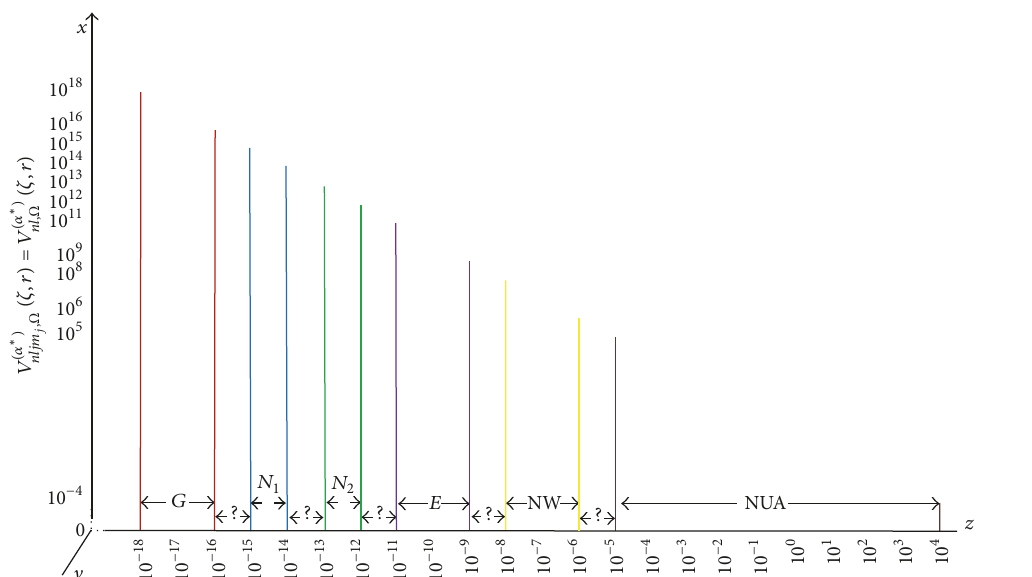
Figure 1: Quantum scalar and SF relativistic NSST potentials for 𝜆 = 0 as a function of distance 𝑟 (for 𝑧 = 𝑟 , 𝑛 = 2 , 𝑙 = 1 , 𝑗 = 1/2 , 𝑚 𝑗 = −1/2 , 𝜁 = 1.5 , 𝛼 ∗ = 0.5 ) for Ω = 𝐺 (10 −18 ≤ 𝑟 ≤ 10 −16 ) , Ω = 𝑁